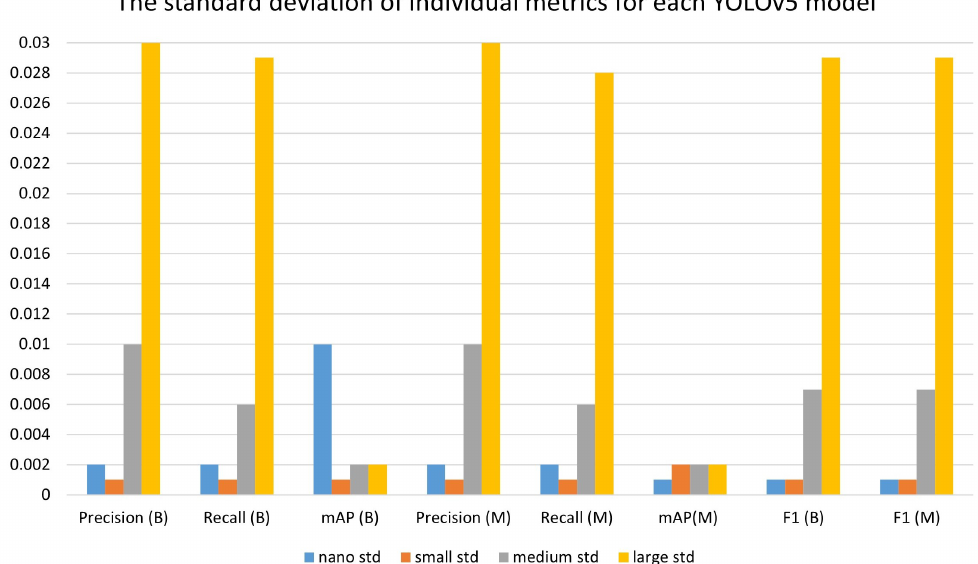
Figure 6. The standard deviation of individual metrics for each YOLOv5